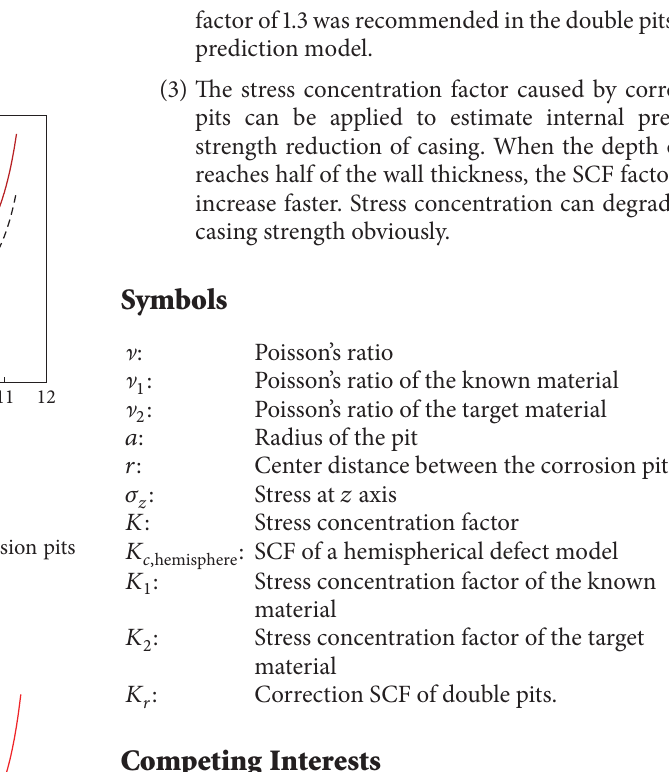
Figure 8: The relationship between stress concentration factor and cavity spacing of steel.